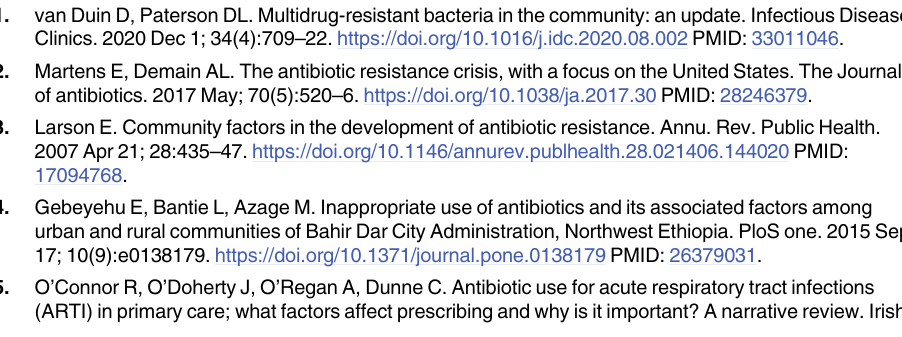
S2 Table. The McIsaac scoring system to use for children and adults with a sore throat to estimate probability of GABHS